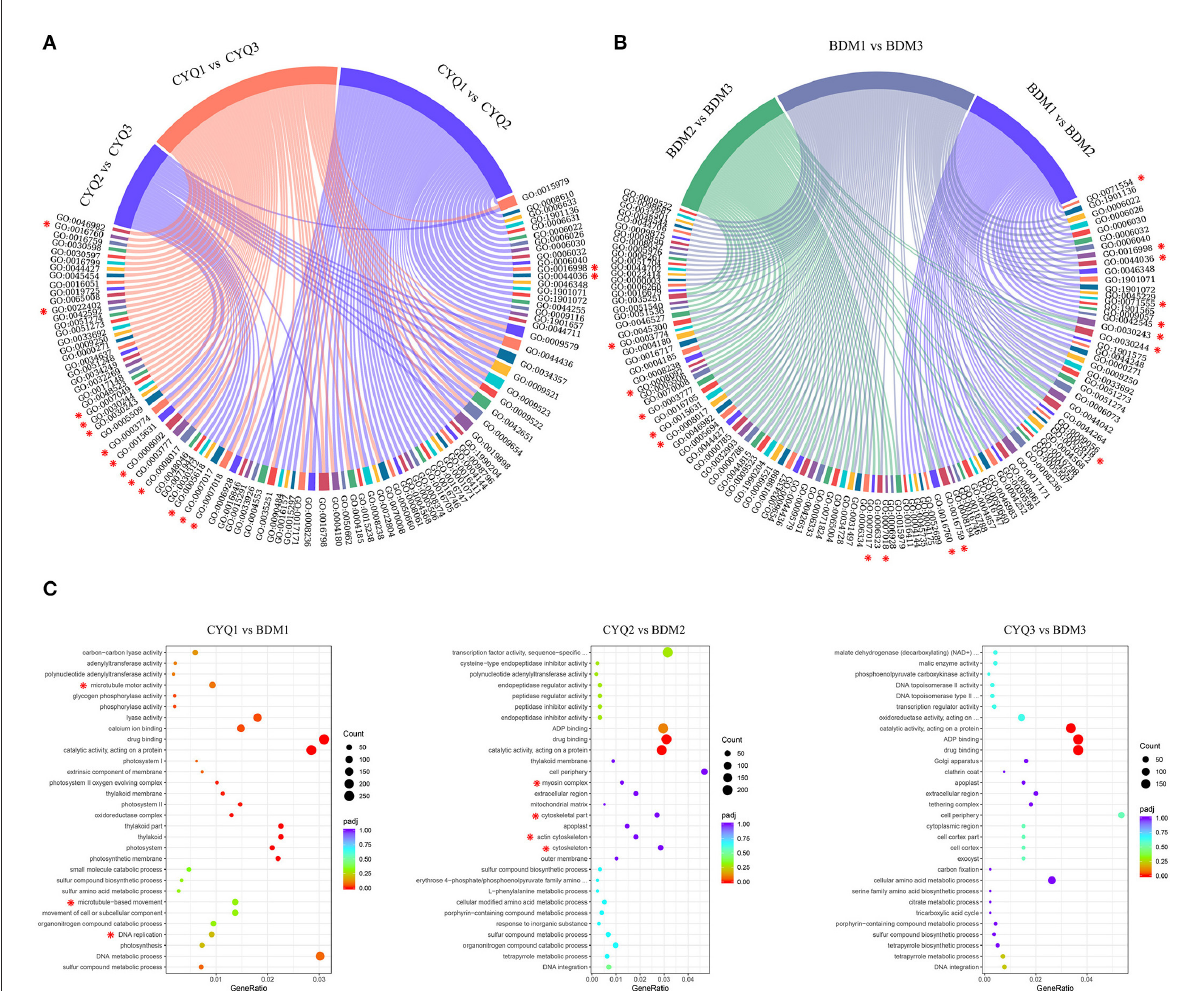
FIGURE4 GO enrichment analysis of DEGs. (A) Overall enrichment terms of DEGs of CYQ1 vs. CYQ2, CYQ2 vs. CYQ3, and CYQ1 vs. CYQ3 comparisons. (B) Overall enrichment terms of DEGs of BDM1 vs. BDM2, BDM2 vs. BDM3, and BDM1 vs. BDM3 comparisons. (C) The top 10 significantly enriched GO terms of BP, CC, and MF categories of CYQ1 vs. BDM1, CYQ2 vs. BDM2, and CYQ3 vs. BDM3 comparisons.